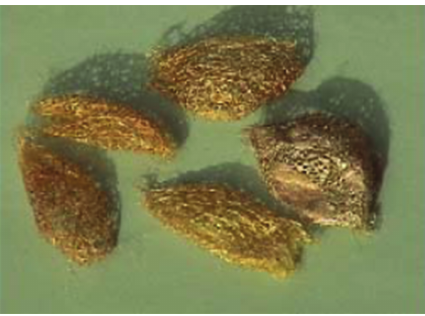
Figure 1: The cocoon shells of the silkworm Cricula triphenestrata